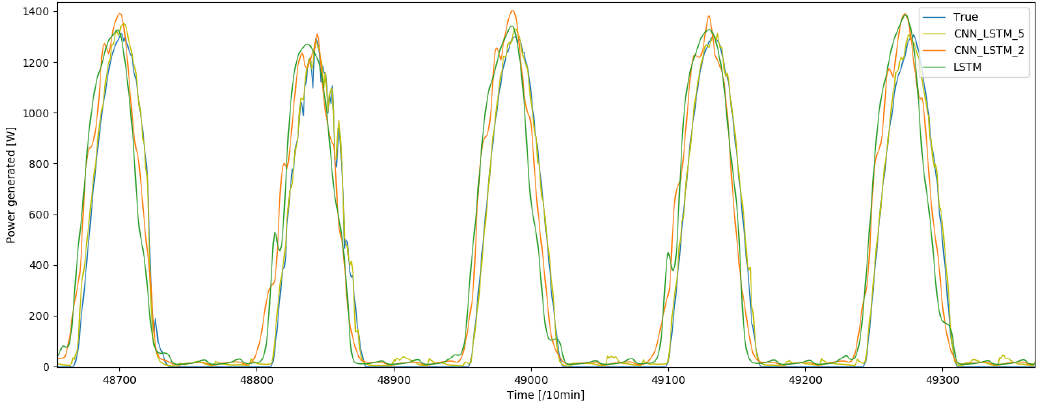
Figure 11. Prediction of PV generation during